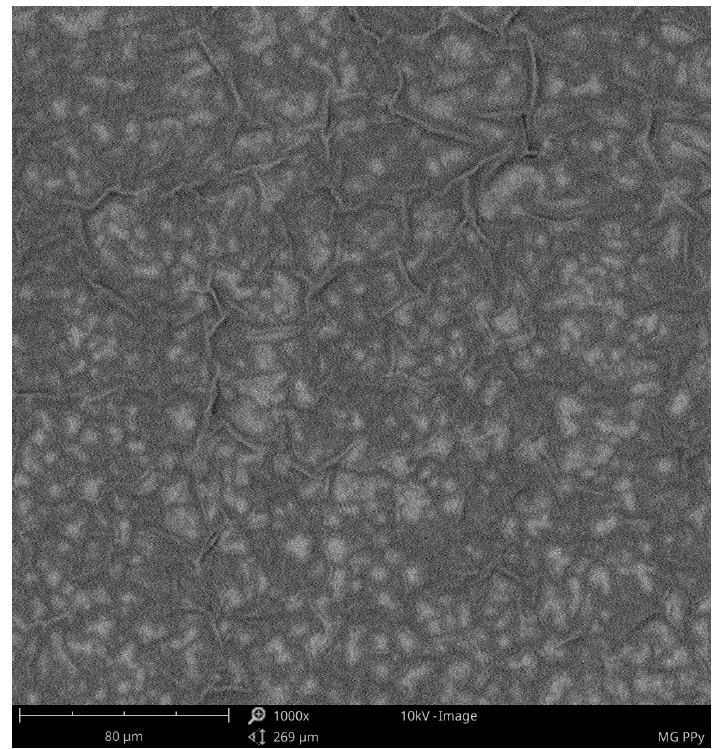
Figure 5. SEM photo of the polypyrrole, zoom × 1000.